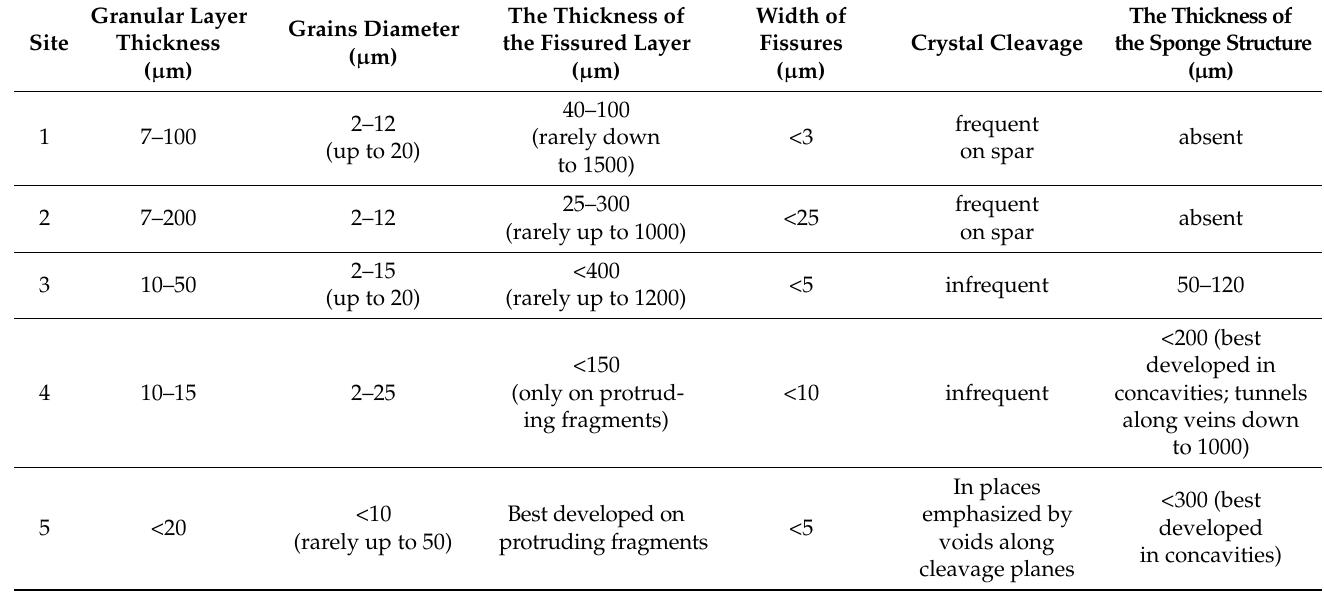
Table 2. Characteristics of weathering rinds (sites 1–5).